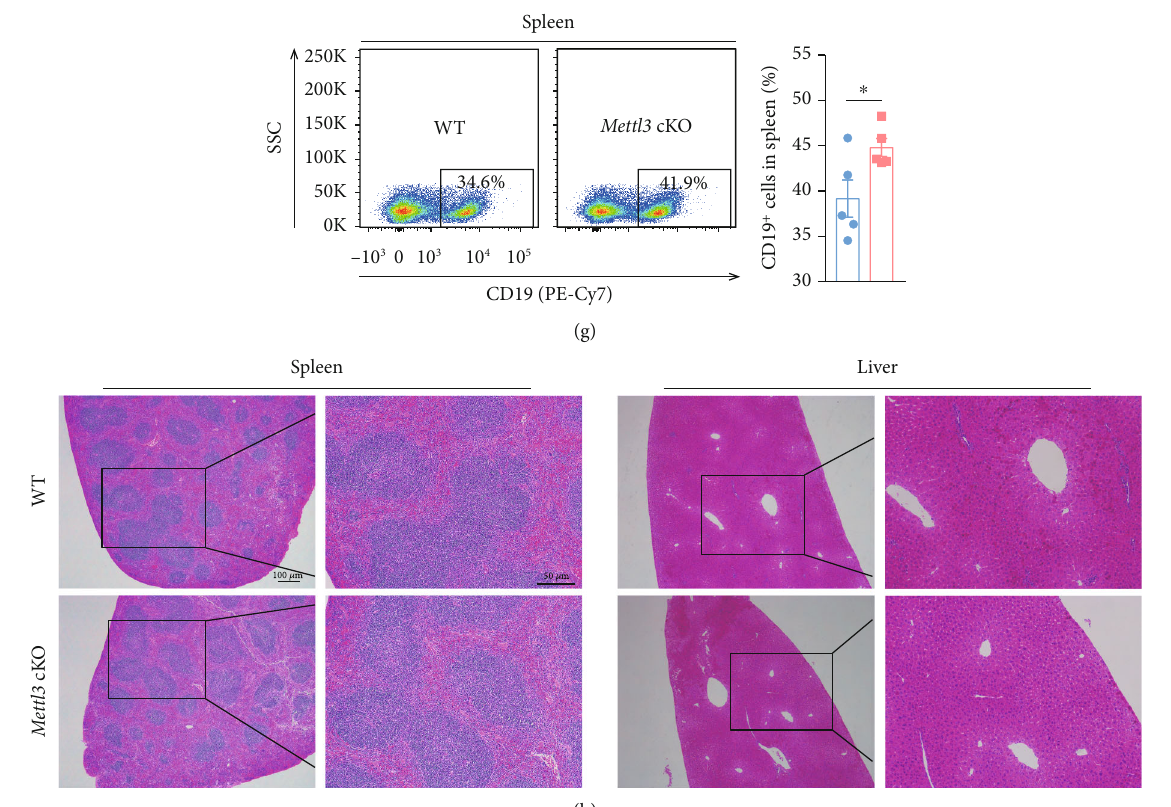
Figure 2: Loss of Mettl3 in Cd19 + cells has minimal e ff ects on mouse development and B cell distribution in peripheral. (a) Body weight of control and Mettl3 cKO littermates at di ff erent time points after birth ( n = 24 /group). (b) The ratio of liver weight to body weight for mice in indicated groups ( n = 24 /group). (c) The ratio of spleen weight to body weight for mice in indicated groups ( n = 24 /group). (d) – (g) Representative fl ow cytometry plots (left) and quanti fi cation (right) for B cell marker CD19 of lymphocytes isolated from peripheral blood (d) ( n = 7 /group), peritoneal cavity (e) ( n = 4 /group), liver (f) ( n = 5 /group), and spleen (g) ( n = 5 /group) at indicated groups. (h) Representative photographs of HE staining of the spleen (left) and liver (right) of WT and Mettl3 cKO mice. Scale bar = 100 μ m and 50 μ m as indicated. Data in (c and g) were presented as means ± SEM with the indicated signi fi cance ( ∗ P < 0 : 05 ; student ’ s t